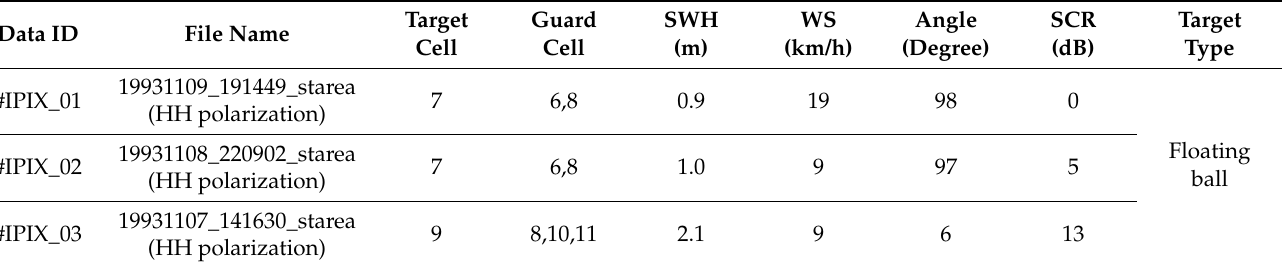
Table 1. Description of the IPIX radar data used in this